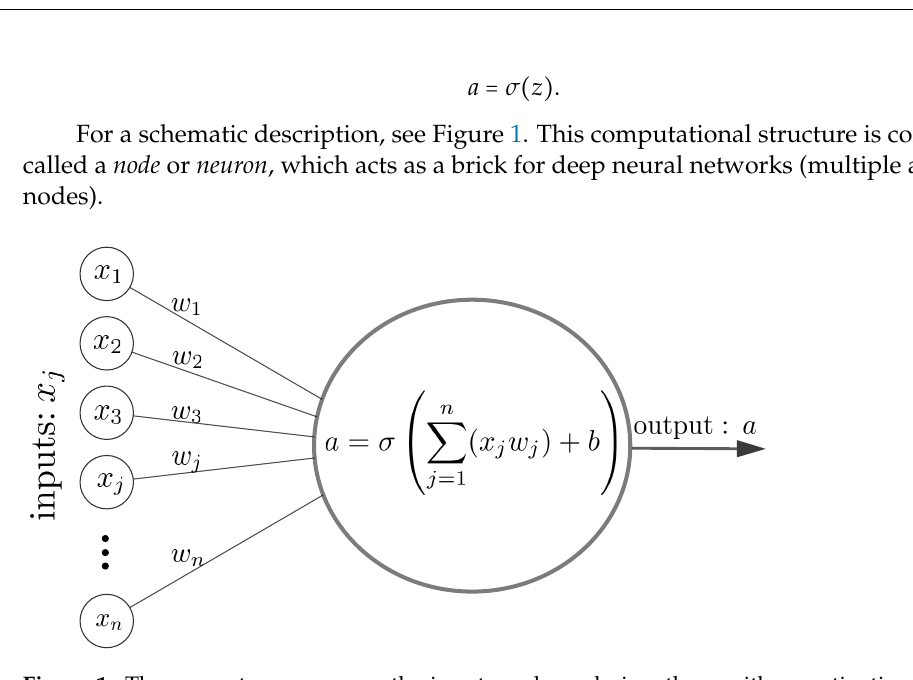
Figure 1. The perceptron processes the inputs and regularises them with an activation function, generating a numerical output.